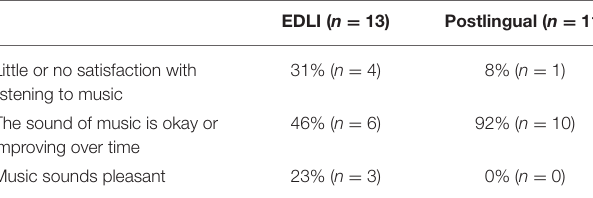
TABLE 3 | The percentages of both groups for the satisfaction with listening to music after implantation. EDLI ( n = 13) Postlingual ( n = 11)